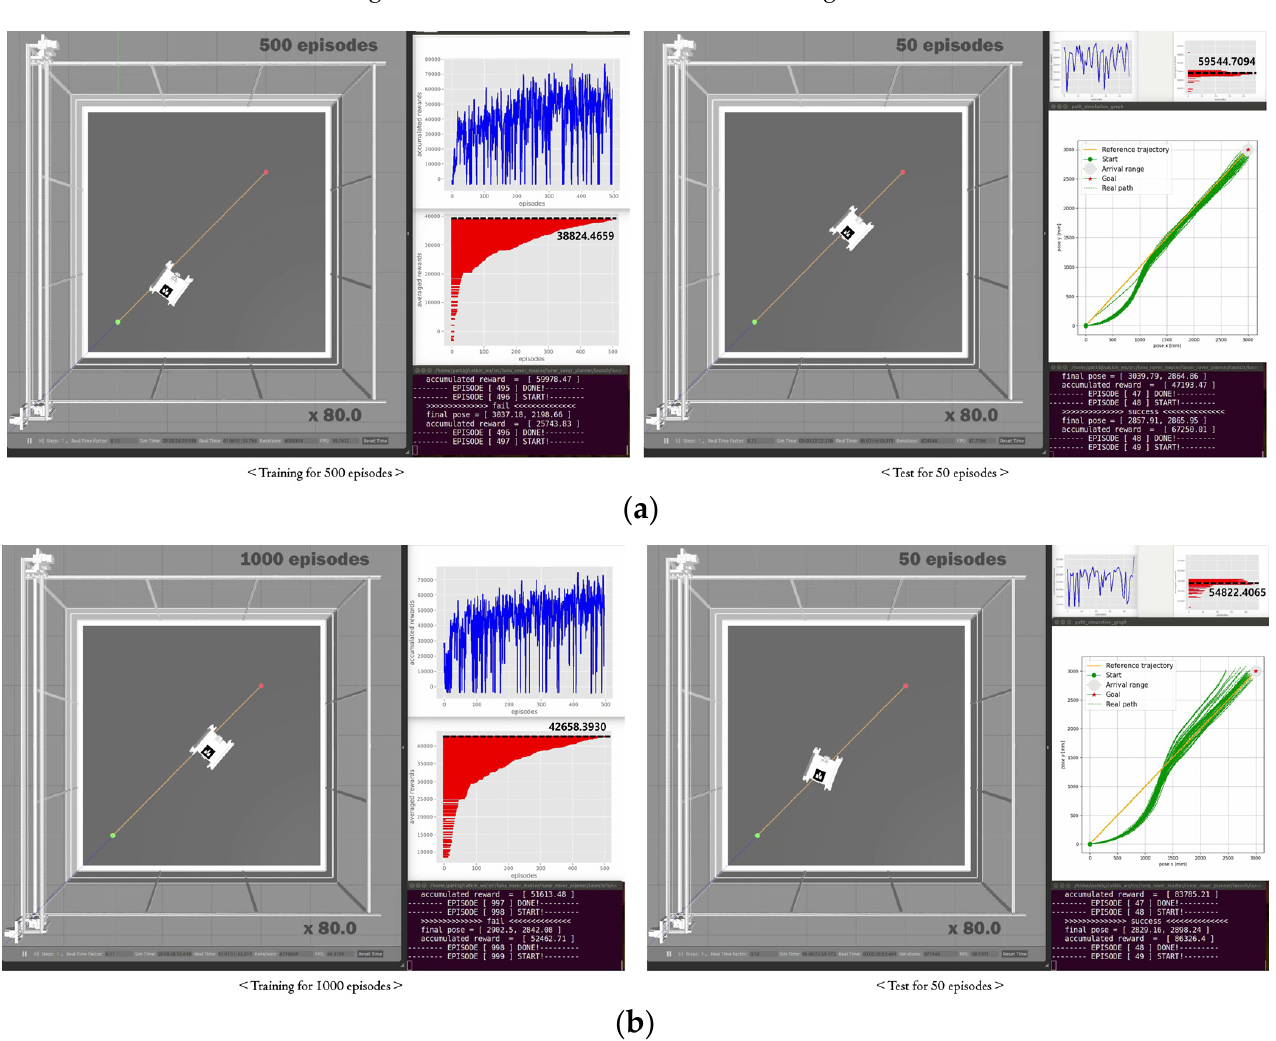
Figure 21. Training episodes (left) and test episodes (right) performed in the respective environments. ( a ) 500 training episodes and 50 test episodes performed in a normal state. ( b ) 1000 training episodes and 50 test episodes performed for the right steering motor failure case.